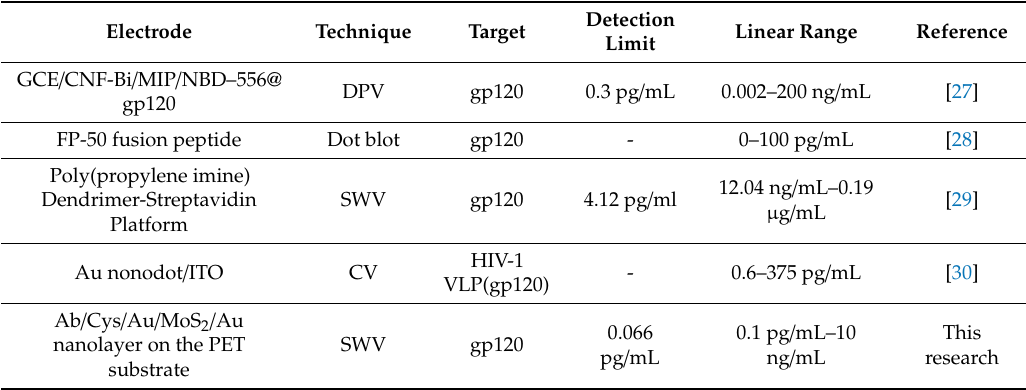
Table 1. Electrochemical biosensors for human immunodeficiency virus (HIV) detection.